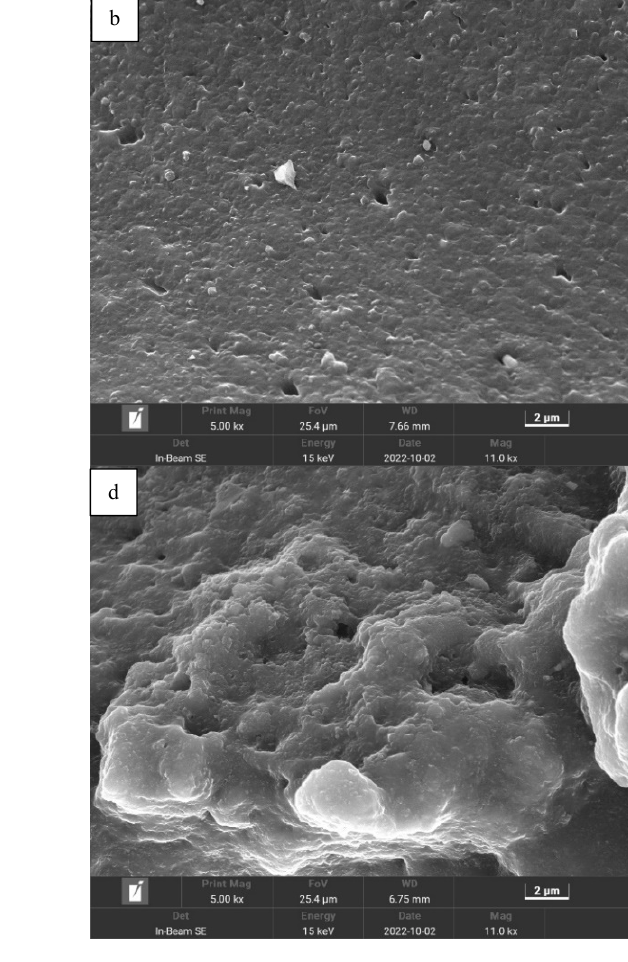
Figure 12. Micromorphology: ( a ) CR 1000×; ( b ) CR 5000×; ( c ) SCR 1000×; ( d ) SCR 5000×.